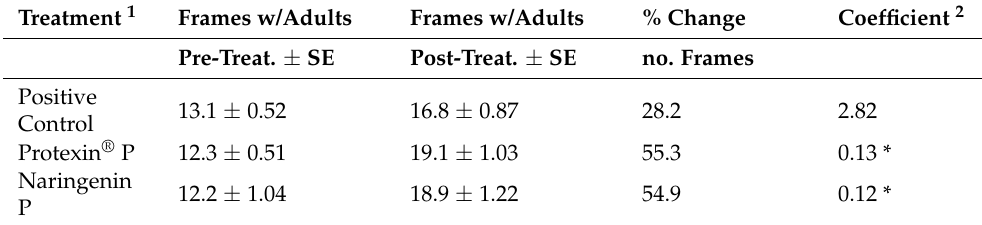
Table 8. Effect of spring 2018 treatments on number of frames covered with adult bees per colony one–two days pre-treatment and nine weeks post-treatment with the prebiotic naringenin or probiotic Protexin ® . Coefficients indicate how the number of frames with adult bees changed relative to the positive control. Means are from 33–34 colonies per treatment.